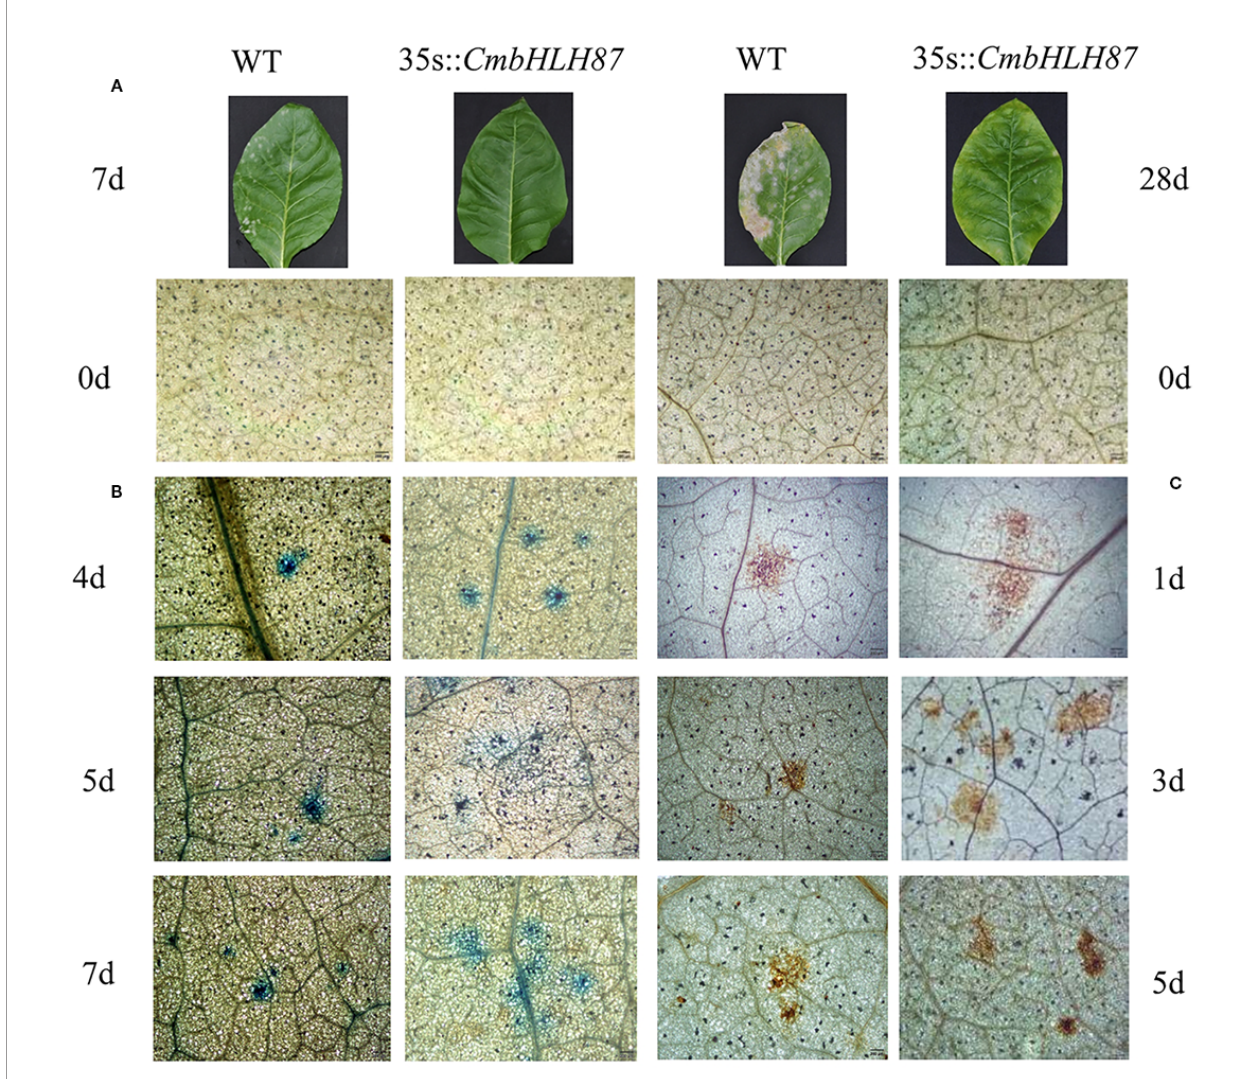
FIGURE 4 | The pathogenic symptoms, trypan blue, and diaminobenzidine (DAB) staining of tobacco leaves infected with powdery mildew. The pathogenic symptoms of transgenic tobacco (L5) and wild type (WT) at 7 and 28 day post inoculation (A) ; trypan blue staining was performed to visualize cell death (B) ; DAB staining was performed to visualize hydrogen peroxide (H 2 O 2 ) accumulation (C) . Scale bars = 200 m